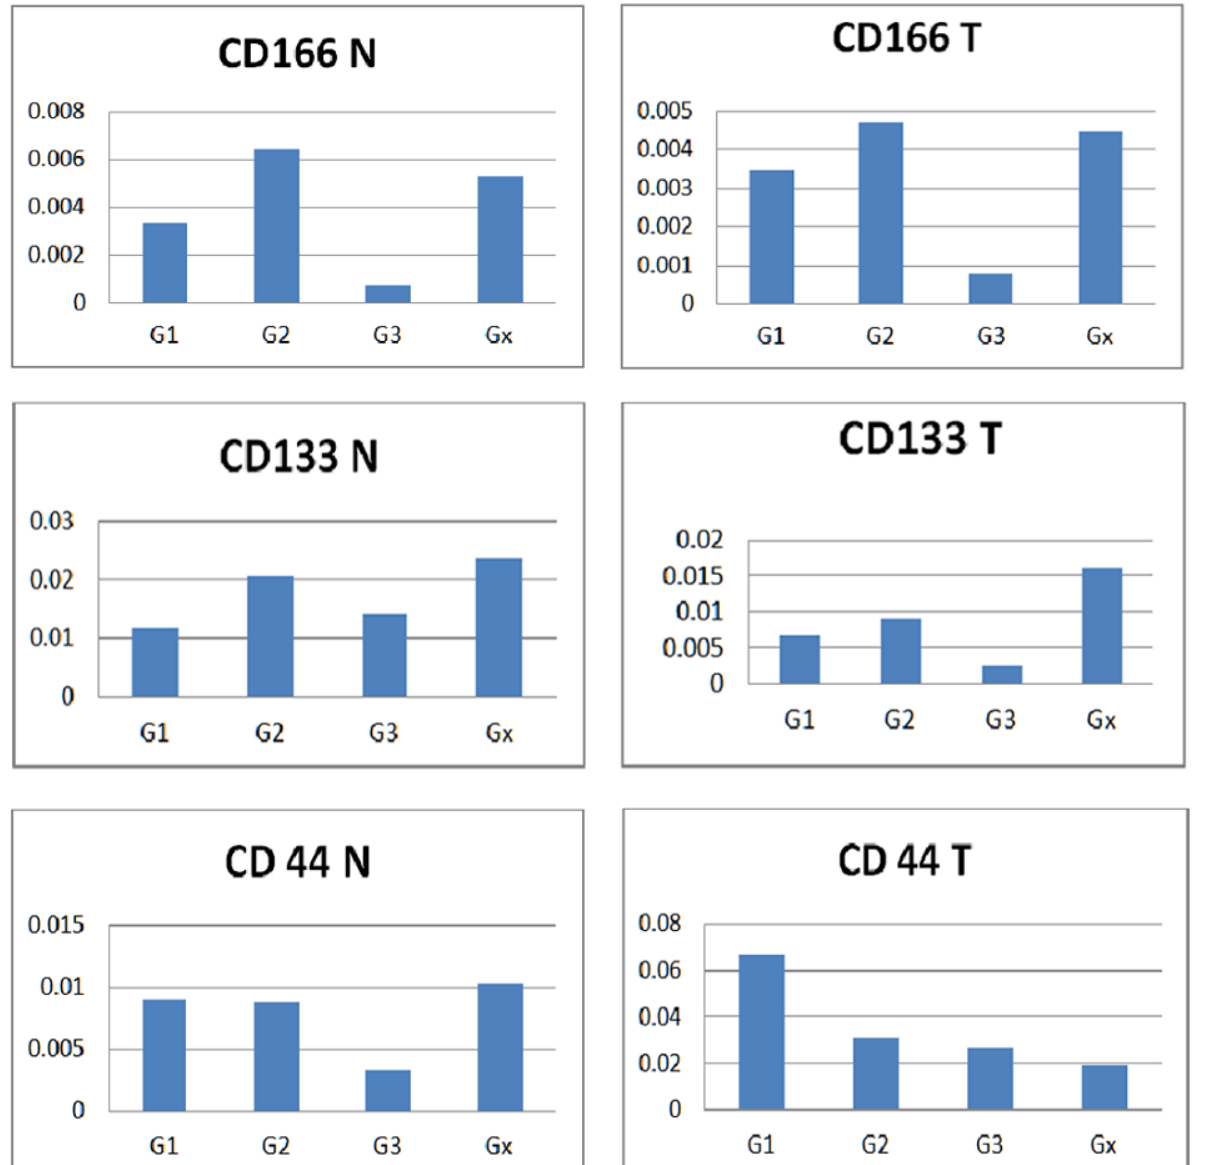
Figure 6. Normal versus tumor tissue expression of the three markers according to tumor grading. A non-parametric Kruskal–Wallis test was used to compare individual groups, and all values achieved statistical significance ( p < 0.05).